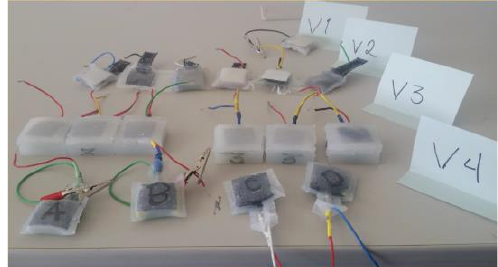
Figure 1 . Different versions of EAP based sensors.